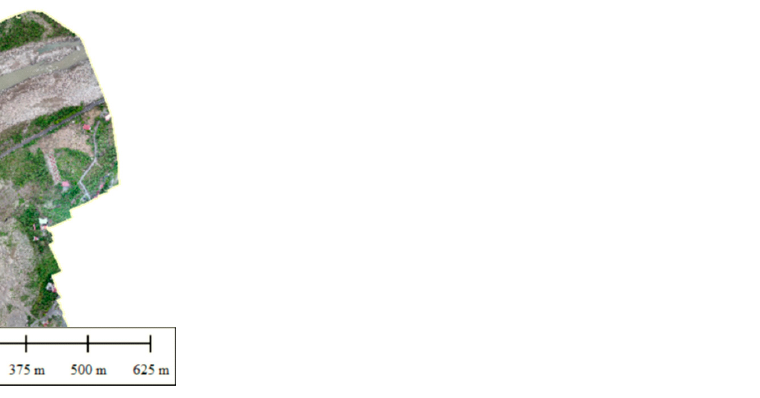
Figure 3. Surveyed bathymetry points in this study. The pink and blue color points were the investigations marks in 2016 and 2017, respectively. The background orthophoto was taken on 10 April 2017.